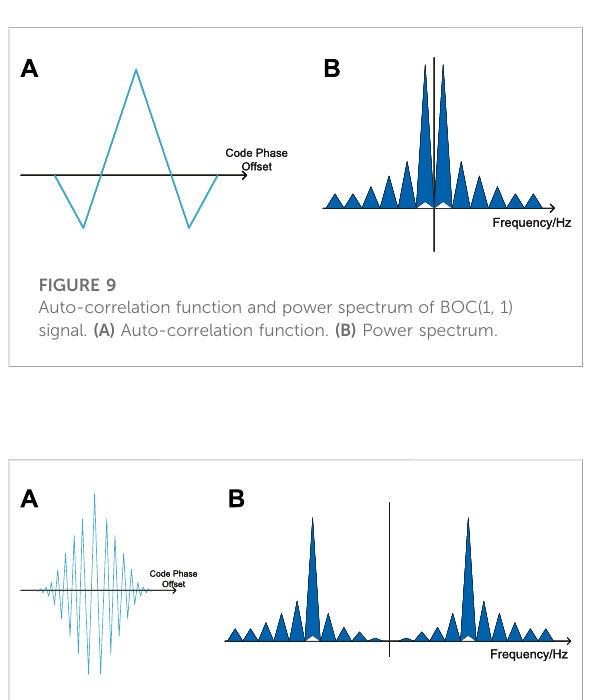
FIGURE 10 Auto-correlation function and power spectrum of BOC(6, 1) signal. (A) Auto-correlation function. (B) Power